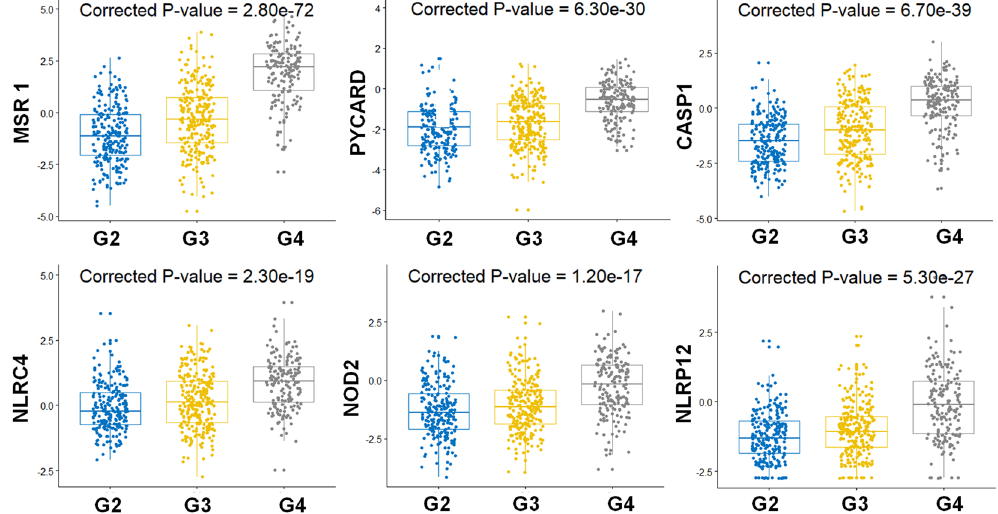
Figure 4. Differential NLR gene expression in different grades of Glioma . The box plots show average gene expression values for differentially expressed genes, MSR1 , CASP1 , PYCARD , NLRC4 , NOD2 and NLRP12 in LGG – grade 2 & grade and GBM- grade 4 glioma. Here, G2, G3 and G4 represents grade 2, grade 3, and grade 4 respectively. We conducted one-way ANOVA followed by posthoc tests using Bonferroni method, to calculate the corrected P-values for the differentially expressed genes in different grades of